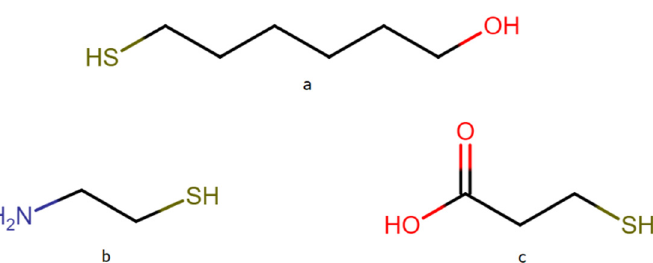
Figure 6. Structure of the alkanethiols: ( a ) 6-mercapto-1-hexanol (MCH), ( b ) cysteamine (CYS), ( c ) 3-mercaptopropionic acid (MPA).